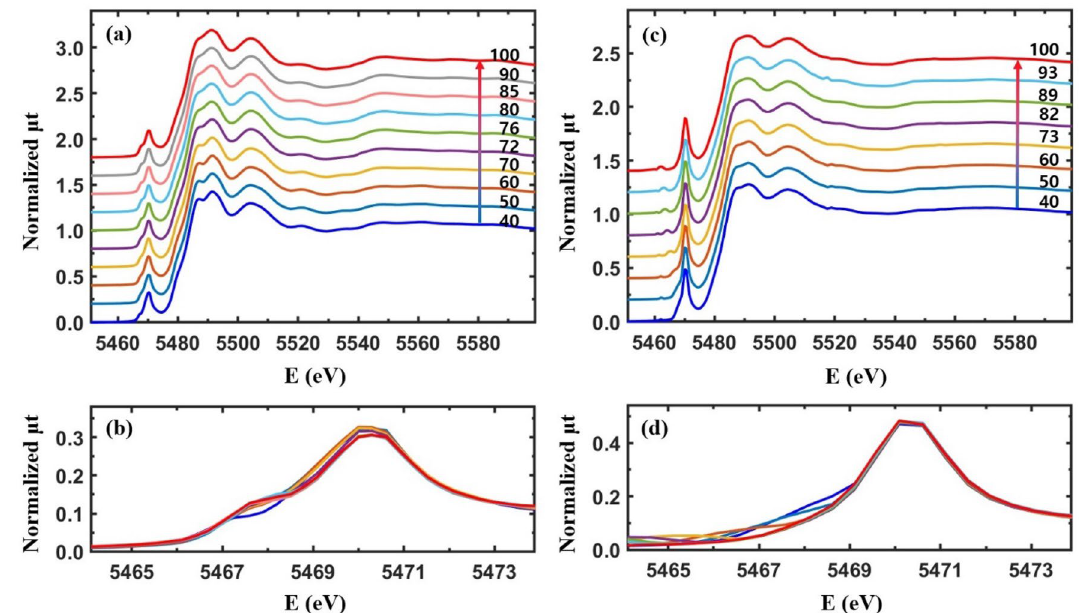
Figure 5. ( a , c ) Temperature-dependent XANES from Cr-VO 2 films with a Cr energy of 50 keV and fluxes of 10 13 ions/cm 2 and 5 × 10 13 ions/cm 2 , respectively. ( b , d ) are the magnified images of the pre-edge peaks in ( a , c ), respectively. Data in ( a , c ) are vertically shifted for clarity.